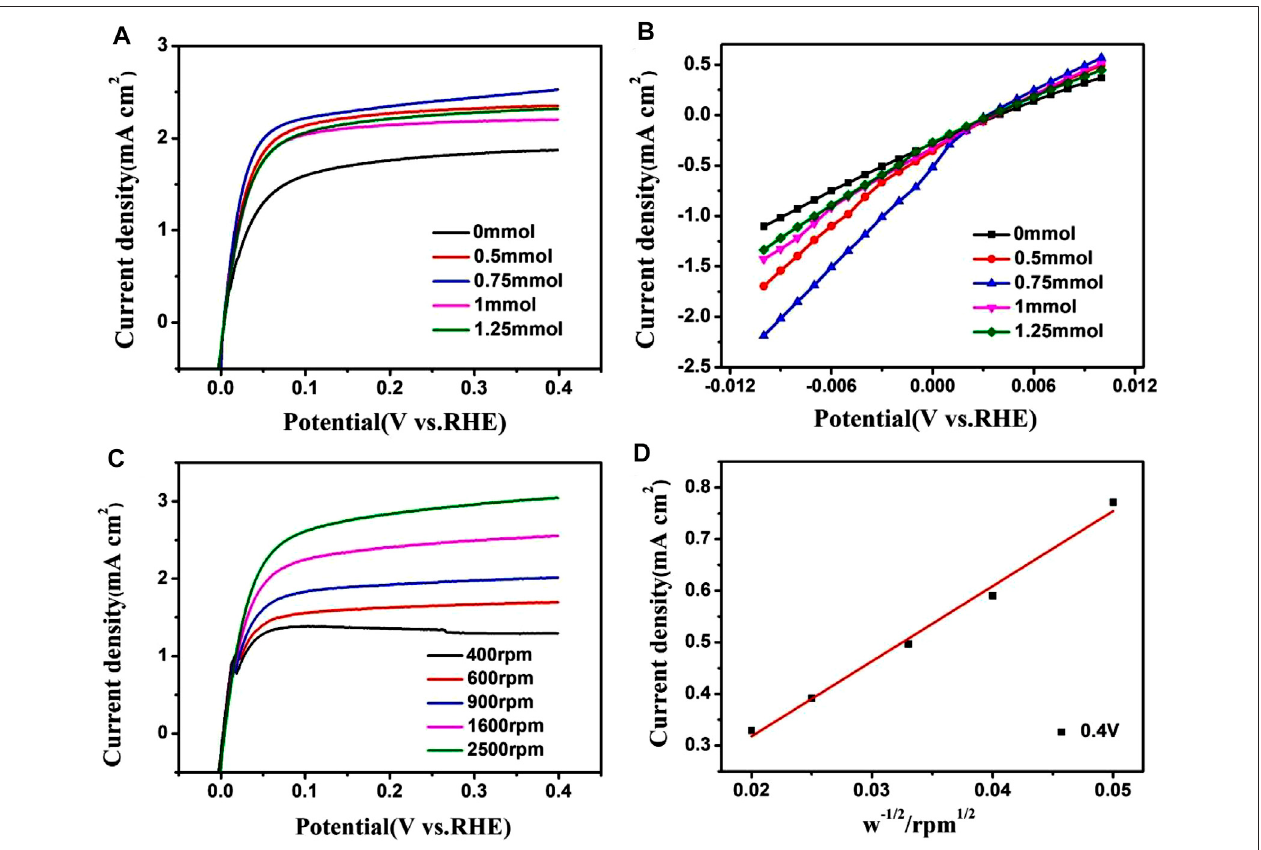
FIGURE 6 | (A) Polarization curves of PtRu/C catalysts in 0.1 M H 2 SO 4 aqueous solution saturated with H 2 at a scan rate of 10 mV s − 1 and rotating speed of 1,600 rpm. (B) The linear-current potential region around the equilibrium potential for hydrogen oxidation/reduction. (C) Polarization curves of PtRu/C-0.75 catalysts in